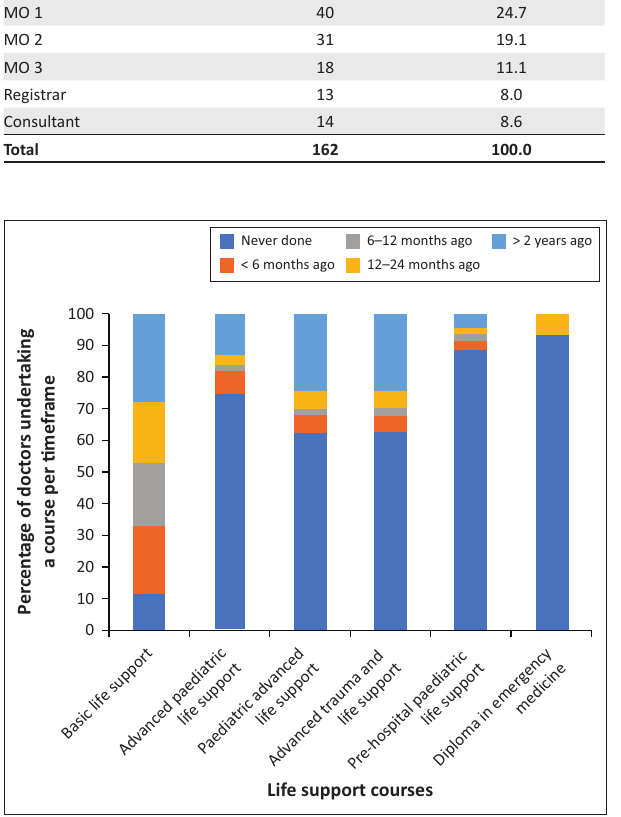
FIGURE 1: Distribution of life support courses done/not done by type of